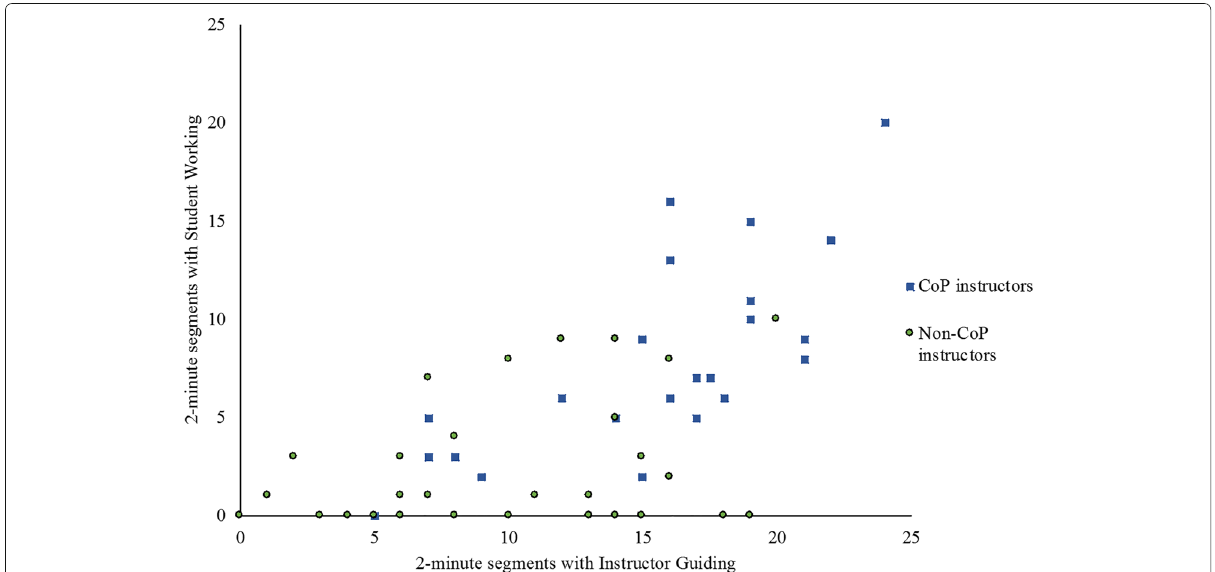
Fig. 3 Instructor and student behavior correlation. Relation of the collapsed COPUS categories of student work with instructor guiding between CoP and non-CoP instructors